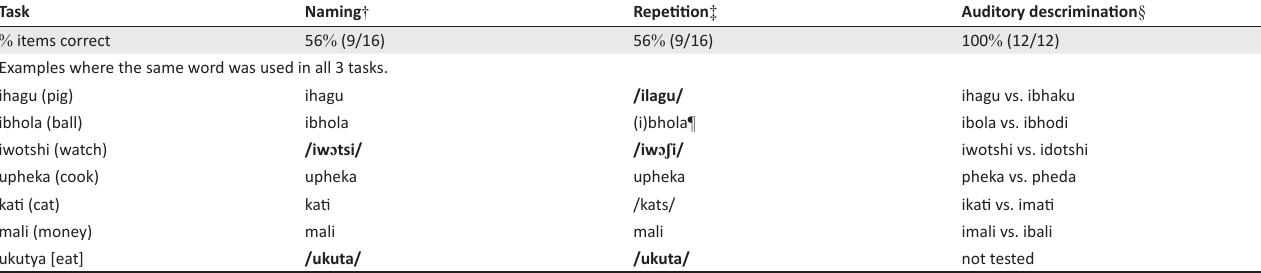
TABLE 2: Summary of Child B’s performance across the three tasks.